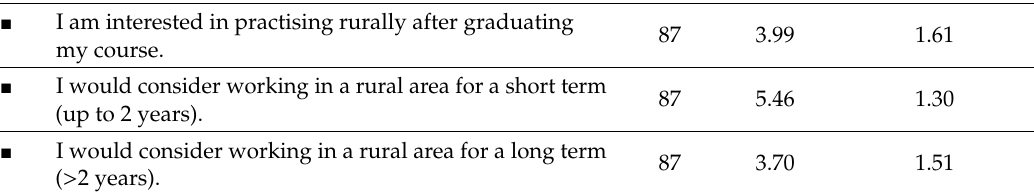
Table 7. Work intention of first-year dental students for rural practice and its association with their gender, age group, ‘rural a ffi liation’ and ‘rural knowledge’.